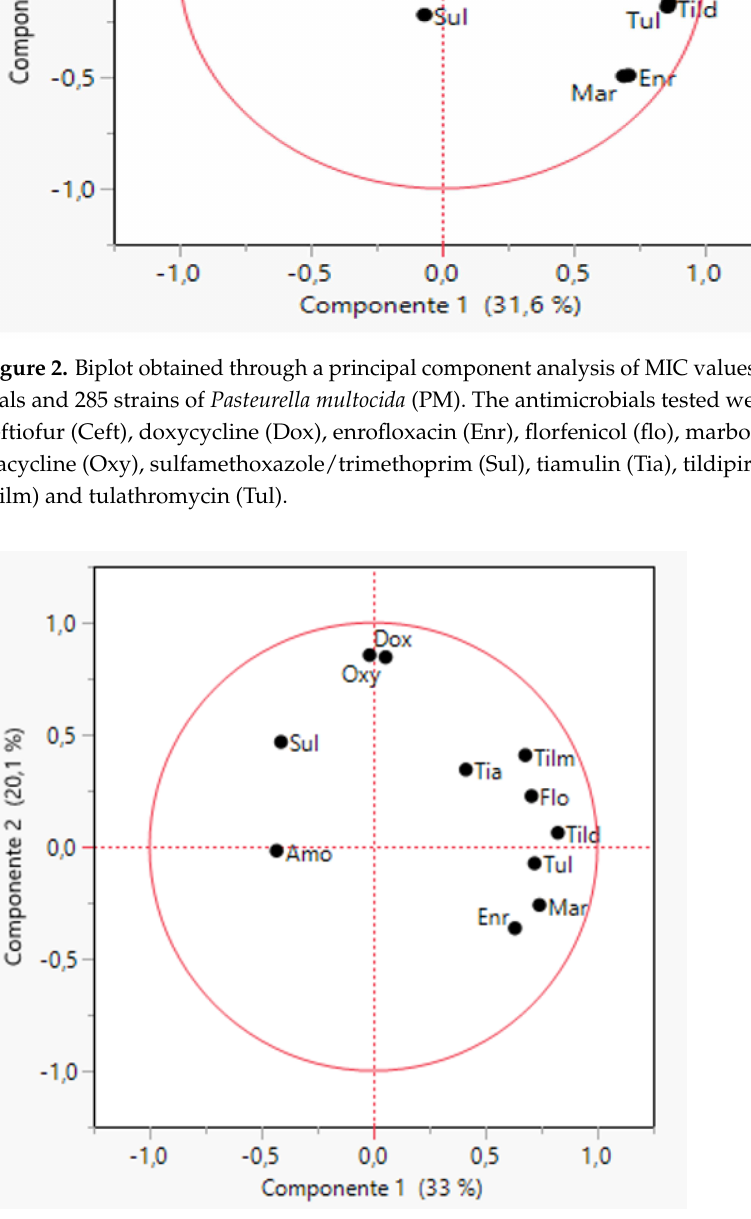
Figure 3. Biplot obtained through a principal component analysis of MIC values for twelve antimi- crobials and 73 strains of Bordetella bronchiseptica (BB) . The antimicrobials tested were amoxicillin (Amo), ceftiofur (Ceft), doxycycline (Dox), enrofloxacin (Enr), florfenicol (flo), marbofloxacin (Mar), oxytetracycline (Oxy), sulfamethoxazole/trimethoprim (Sul), tiamulin (Tia), tildipirosin (Tild), tilmicosin (Tilm) and tulathromycin